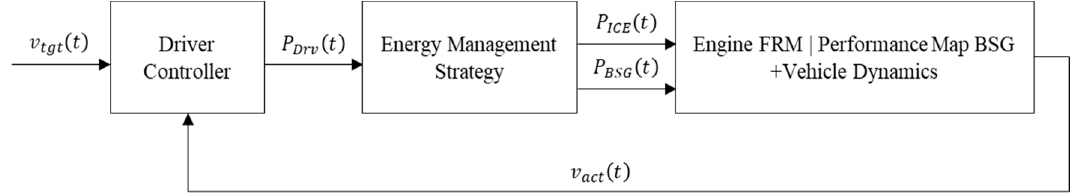
Figure 2. Schematic representation of the hybrid control strategy.